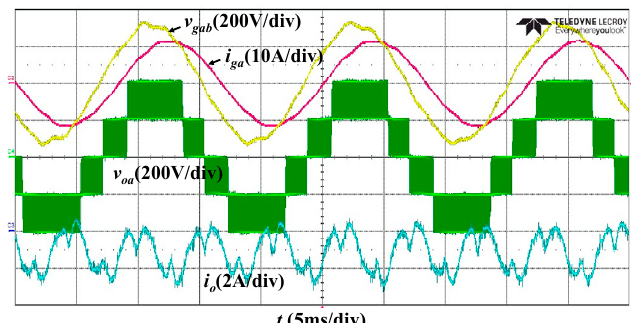
Figure 9. Photograph of the experimental prototype.